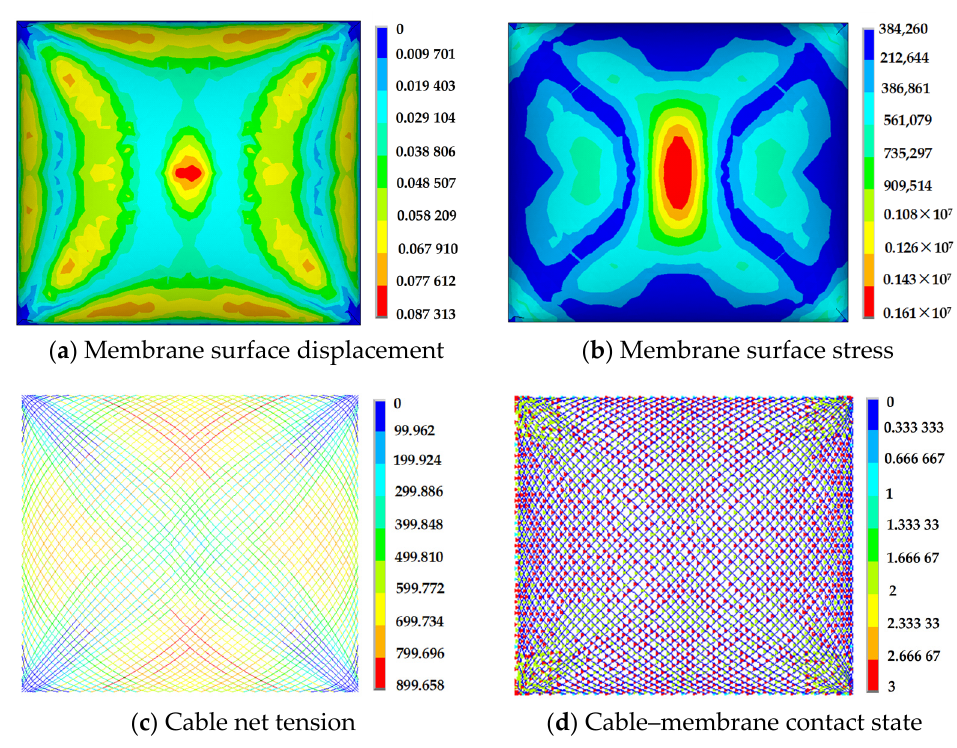
Figure 9. Cable–membrane internal force in sliding contact state.